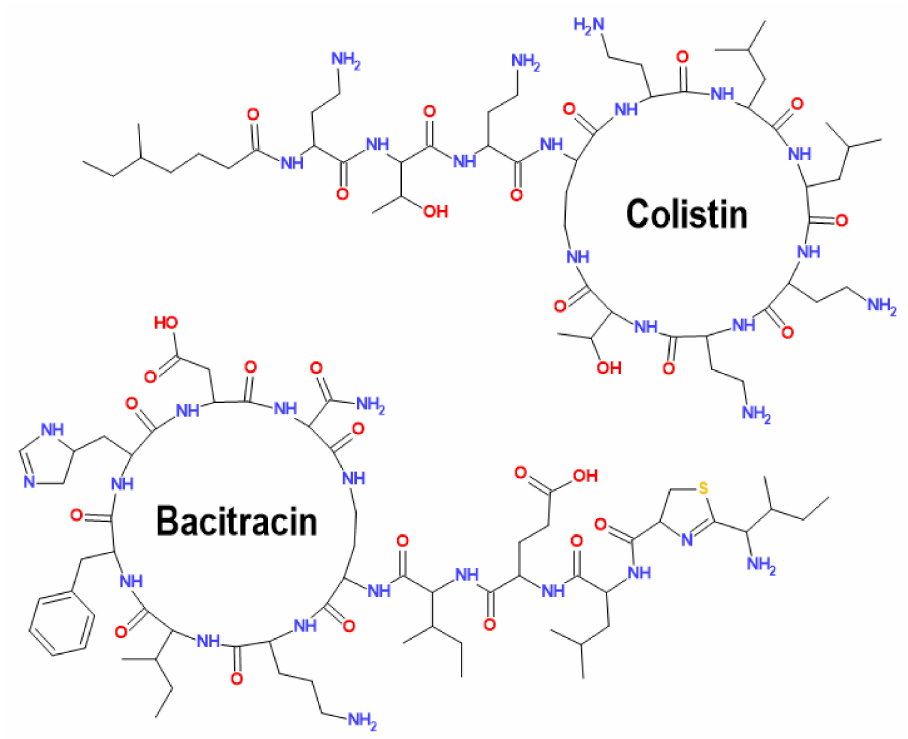
Figure 1. Structural formulas of the peptide antibiotics bacitracin and